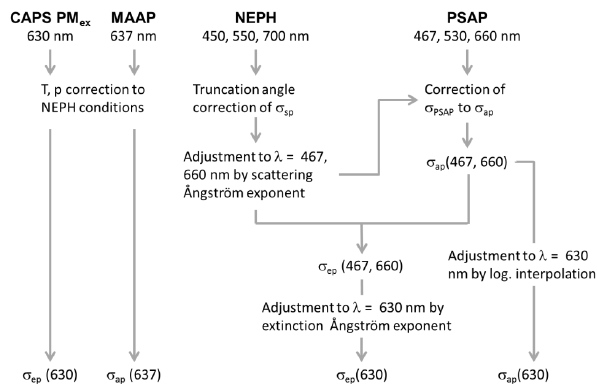
Figure 3. Schematic of the data inversion procedures for the optical instruments. Fig. 3. Schematic of the data inversion procedures for the optical instruments.